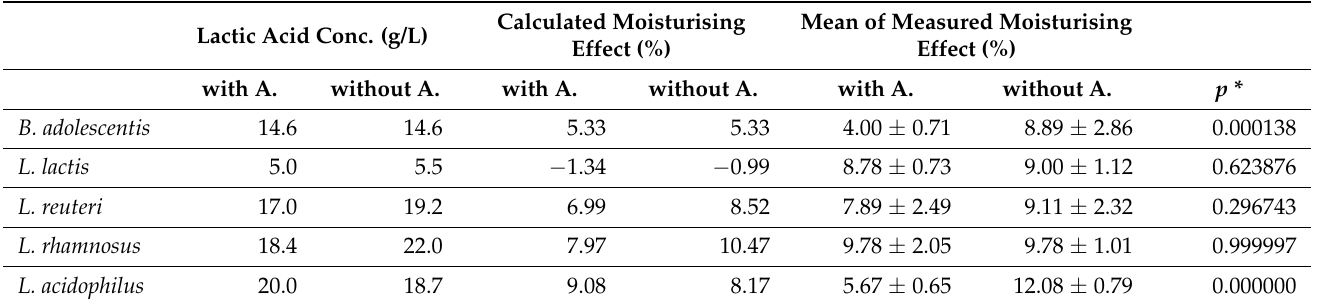
Table 1. The calculated moisturising effect of ferment filtrates according to their lactic acid concentra- tion with the measured results.